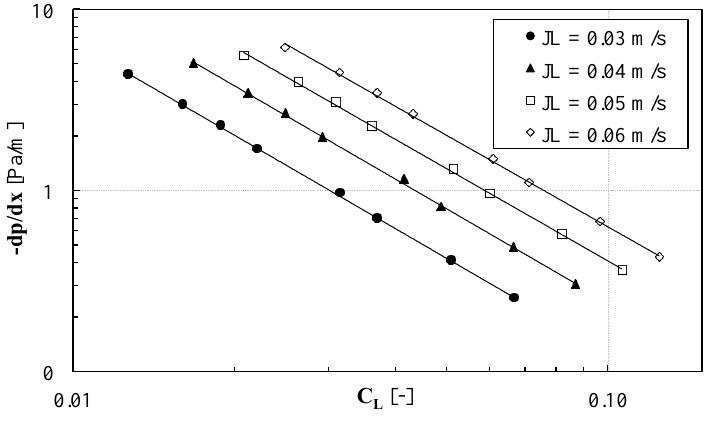
Figure 6. Pressure gradient vs. water cut.